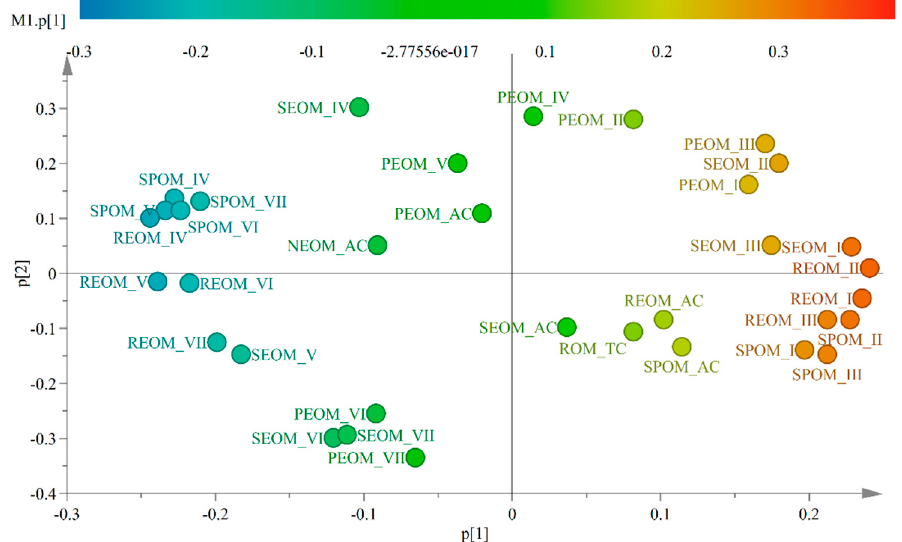
Figure 4. Loading scatter plot for the first two principal components. (The color scale indicates the contribution of 34 variables on the first component. SPOM − soluble fraction from particular extractable organic matter; REOM − readily extractable organic matter; SEOM − slowly extractable organic matter; PEOM: poorly extractable organic matter; AC − apportionment of carbon in corresponding fraction; I − VII − fluorescence proportions of seven zones in the corresponding fraction, the mark “P f ” was removed to reduce the length of labels.)